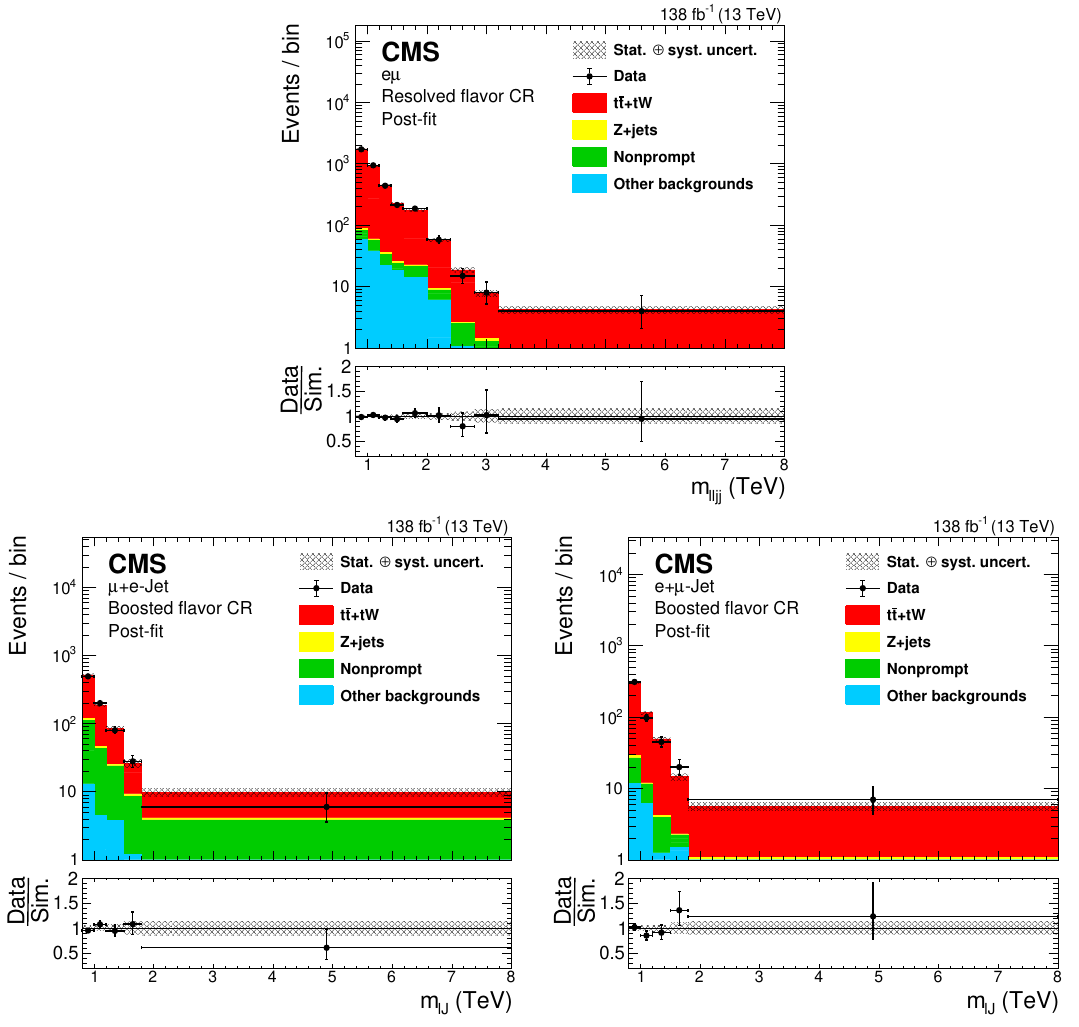
boson in the resolved (upper), boosted with e -jet R